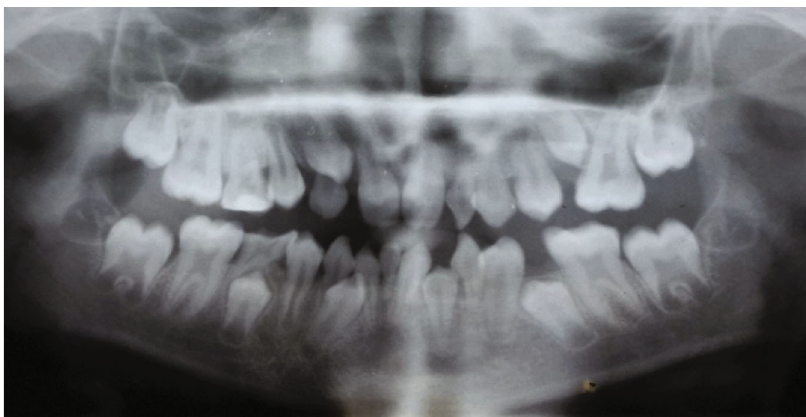
Figure 4: Preoperative photoimage of dental panoramic